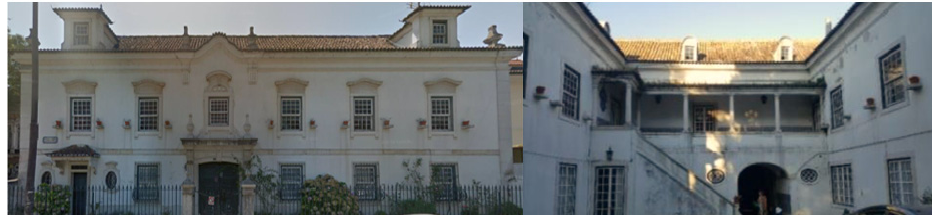
Figure 4. Images of the front and rear façades of “Casal de São José” [9].